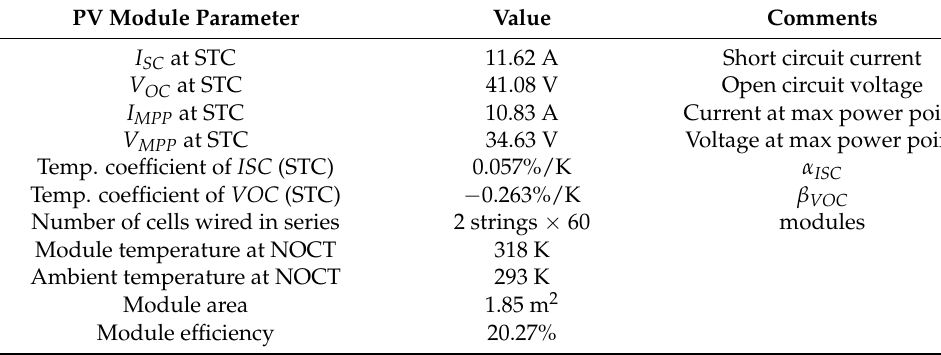
Table 2. Technical data of the 375 Wp monocrystalline silicon, 120 half-cells PV panels NU JC375 [32], as used in type194. PV Module Parameter